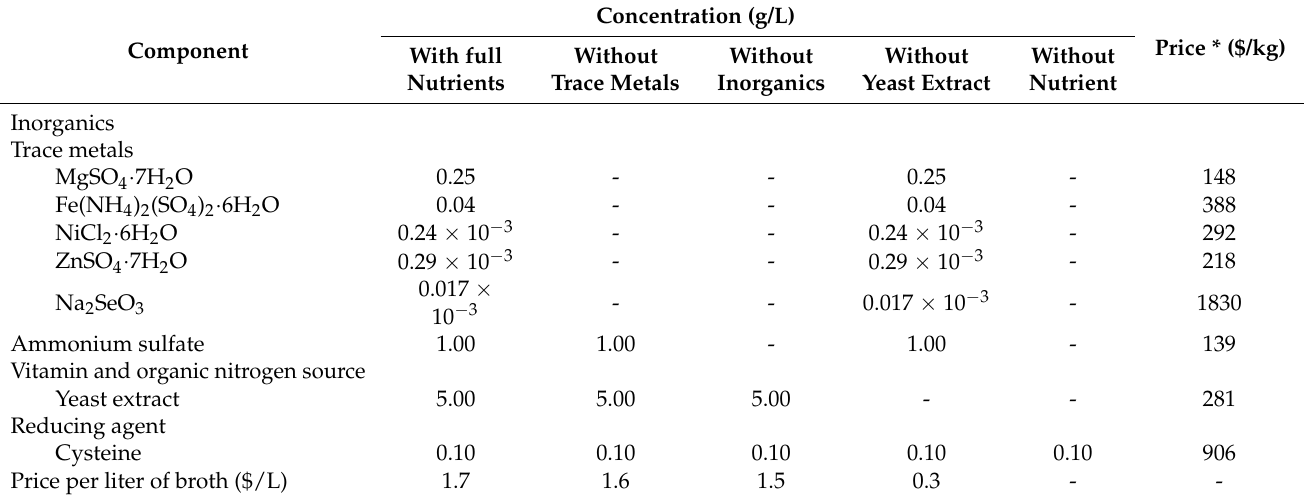
Table 1. Classification, concentration and price of nutrients used for fermentation with M. thermoacetica